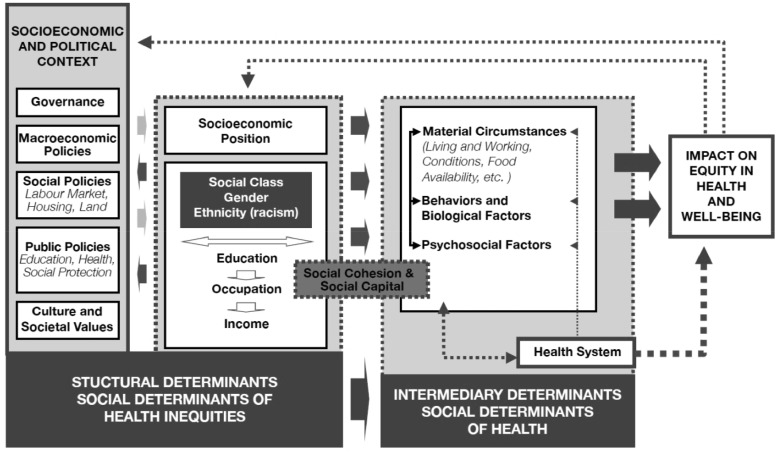
The Social Determinants of Health conceptual framework. Source: Solar and Irwin [Solar and Irwin (2010), p. 6].